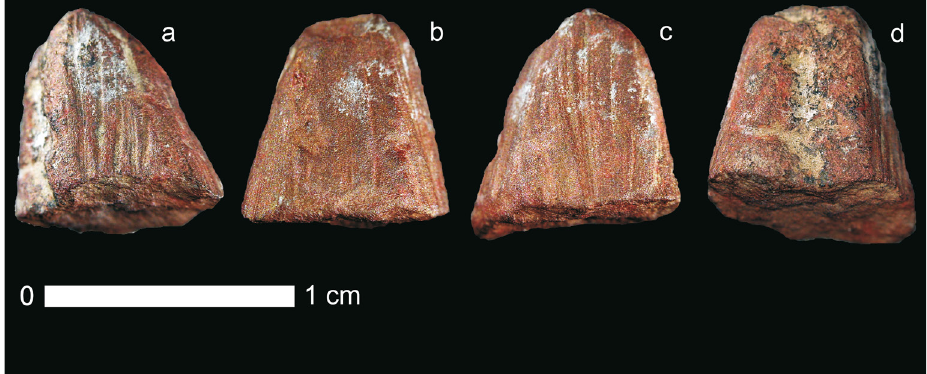
Figure 8. Hohle Fels, “crayon”-shaped artifact made from ochre, excavated 2009, four views. Photo: M. Malina. The Rondelle consists of three separate fragments, two of which fit together (Find 110/1104.1 & 110/992) (Fig. 9). The latter come from AH IIad. When combined, these pieces construct a unique artifact, as the nature of modification suggests that the pieces were shaped and not necessarily used for acquiring pigment, though both scenarios could have occurred simultaneously. Together, the two refitted pieces are made of the same hematite rich material and measure 3.4 x 2.1 x 0.4 cm (Conard & Malina, 2011). The outer edge of the complete ochre artifact depicts the arc of a circle, with a ground hole in the center. Its appearance suggests a pendant; however, the exact function of this object is unclear. Further micro-wear and residue analyses of the central perforation may provide more information. The smaller third piece (Find 110/434.1), which also appears to be hematite, measures 2 x 1.4 x 0.1 cm and was uncovered in AH IIad. Even though there is no evidence of a ground central hole, the rounded edges show clear striations indicating that grinding on a hard stone was the primary shaping mechanism. Though the smaller piece does not refit with the larger, the similar rounded edge suggests the pieces were originally comparable in their appearance and function.